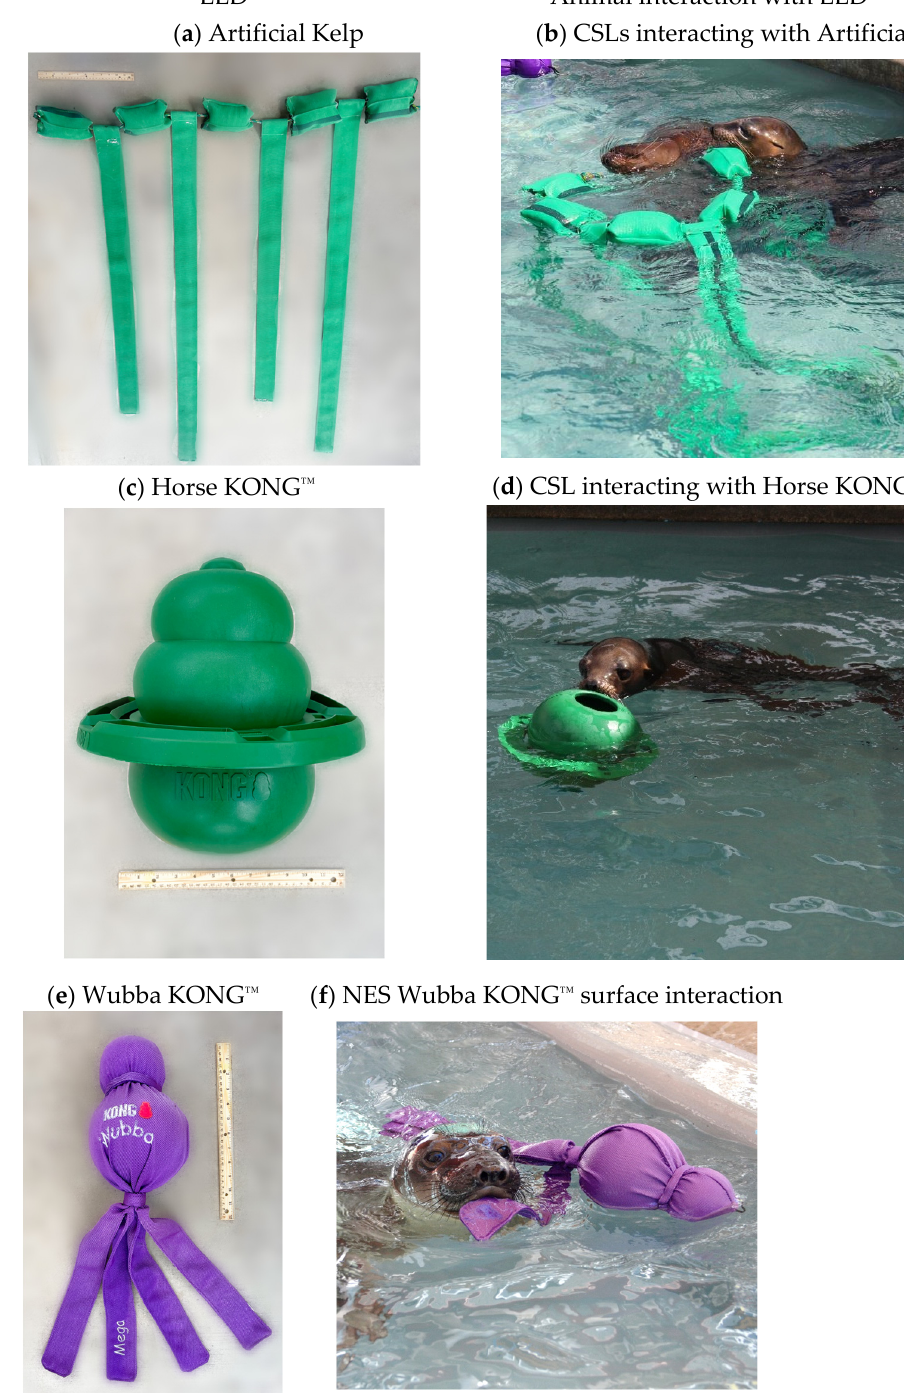
Figure 1. Photos of all EEDs used in this study, and examples of animals interacting with EEDs: Arti fi cial Kelp ( a , b ), Horse KONG ™ ( c , d ) and Wubba KONG ™ ( e , f ).